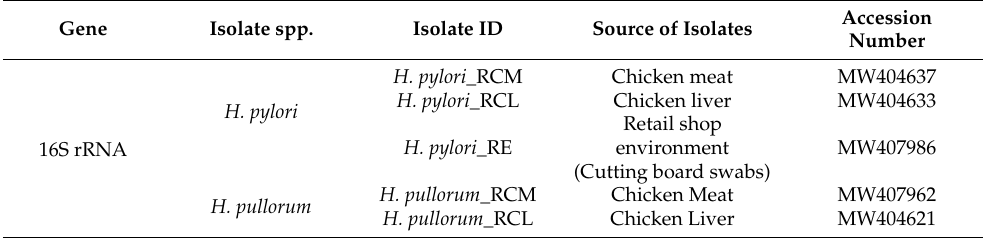
Table 3. The accession numbers of 16S rRNA gene sequence of the selected five Helicobacter species. Gene Isolate spp. Isolate ID Source of Isolates